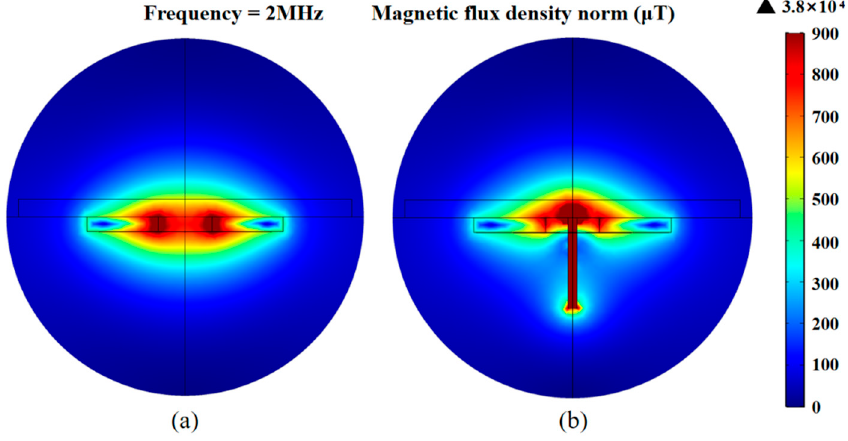
Figure 2. The simulation results of the magnetic field: ( a ) the magnetic field distribution of a planar coil; ( b ) the magnetic field distribution of a planar coil with a silicon steel strip.